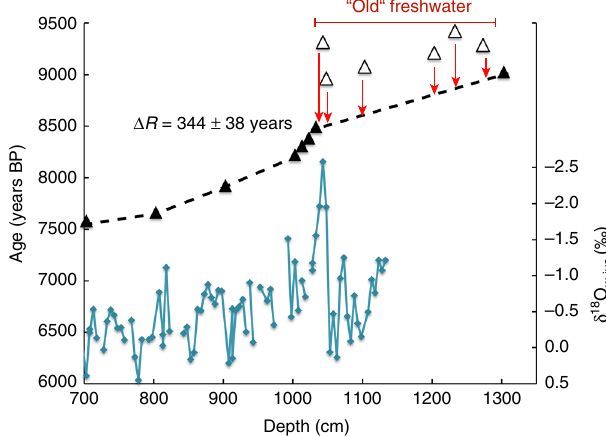
Fig. 3 Age – depth relationship of calibrated accelerator mass spectrometric (AMS) dates in core MSM45-19-2. The δ 18 O w-ivc record (blue line) is plotted against core depth (700 – 1303 cm). All AMS dates were calibrated with Δ R = 344 ± 38 years 40,41 . Black triangles mark the calibrated